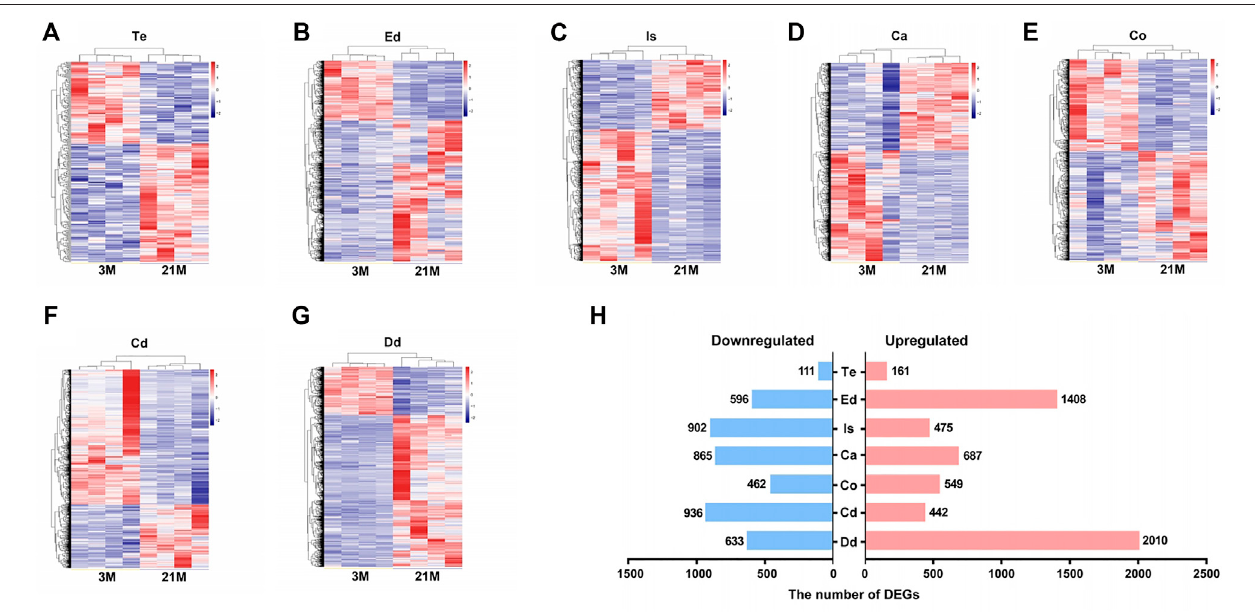
FIGURE 4 | Age-related transcriptional changes in the male reproductive tract. (A – G) Heatmaps of age-related differentially expressed genes (DEGs) in seven regionsfrom3-month-old ( n (cid:2) 4)and 21-month-old( n (cid:2) 4)mice.Geneswithfoldchange ≥ 1.5(upregulatedordownregulated)and p < 0.05werede fi ned asage-related DEGs. (H) Numbers of age-related DEGs. (I) Upset plot shows the intersection of the upregulated DEGs and (J) downregulated DEGs. (K) Gene Ontology (GO) enrichment analysis of the upregulated DEGs and (L) downregulated DEGs. Te: testis; Ed: efferent ductules; Is: initial segment; Ca: caput; Co: corpus; Cd: cauda; Dd: ductus